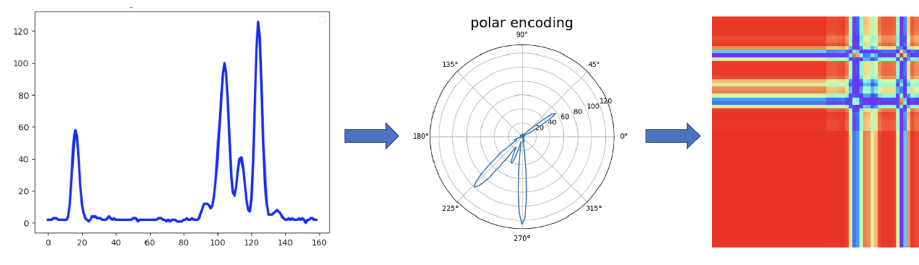
Figure 5. Workflow of full-waveform transformation.